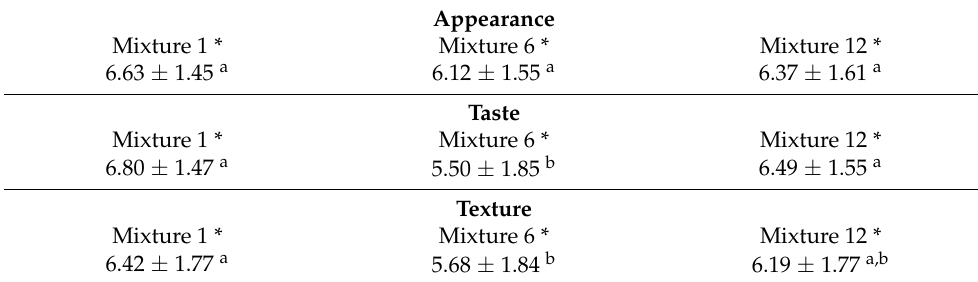
Table 5. HSD Tukey means